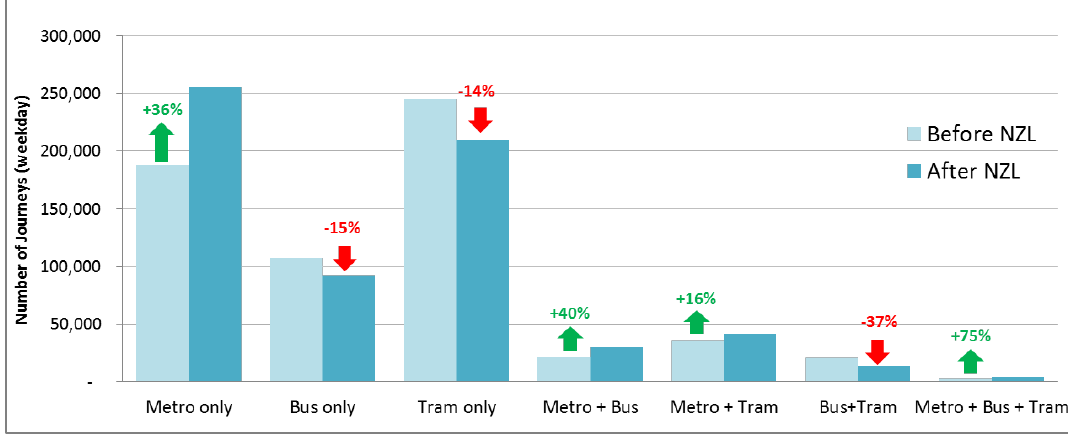
Figure 7. Change in ridership by mode(s) used